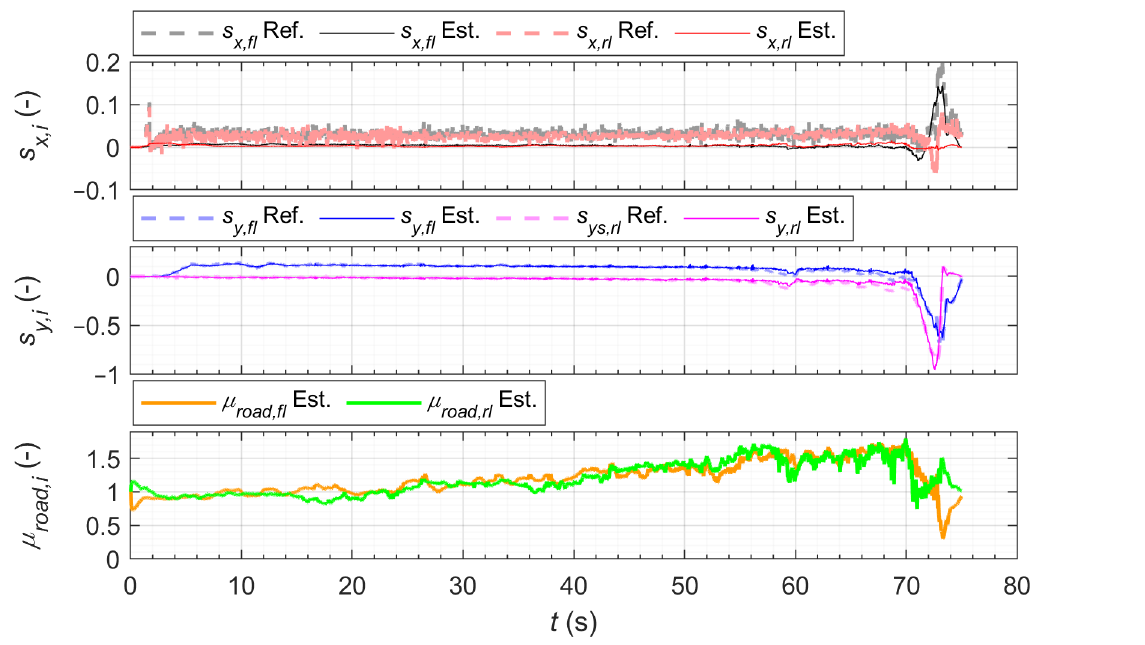
Figure 8. Test data—circular steady-state driving maneuver on dry road surface: measured and estimated tire slip for the front left and rear left wheels as well as estimated tire model adaption parameter.